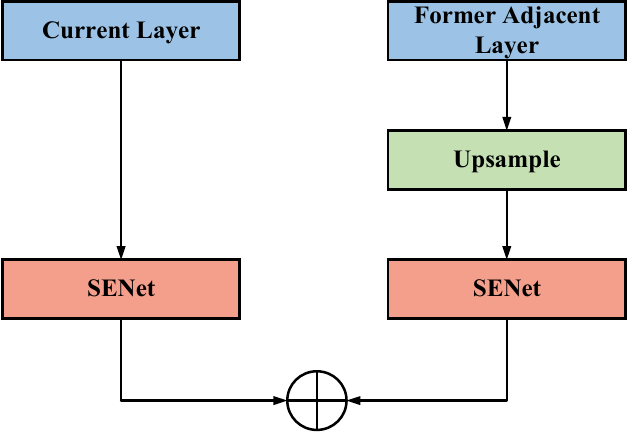
Figure 6. Schematic diagram of attention fusion module (AFM).